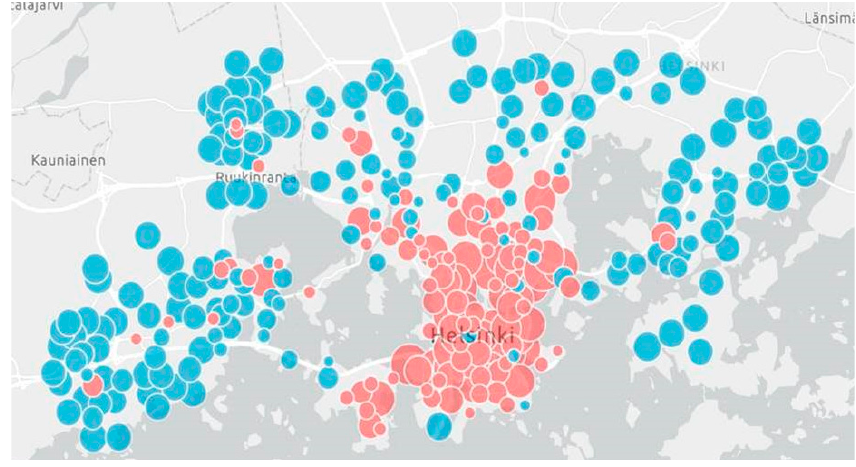
the station should reduce in size) and the stations latitude and longitude. Other parame ‐ ters are the change in the number of slots and in this case the model suggests that the Figure 2. The proposed adjustment in the size of the stations using data from direct passive participation. station should grow by 46.81 slots. The name of the station and the existing number of slots are also displayed. This visualization can be shown for any of the 3080 stations. The calculation model suggests a new size for every station in the network. Figure 3 below displays the details of one particular bike station called Kalasataman Metroasema. Each circle in the visualization displays 6 parameters when selected. These parameters include the sign of the change (1 indicates that the station should grow, − 1 indicates that